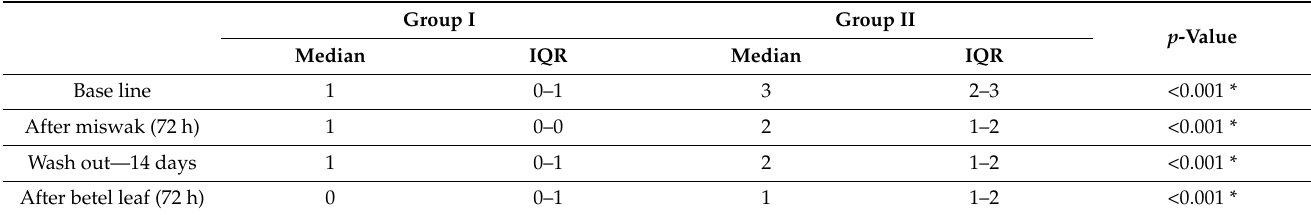
Table 3. Comparison of Bleeding score between the groups at each visit.